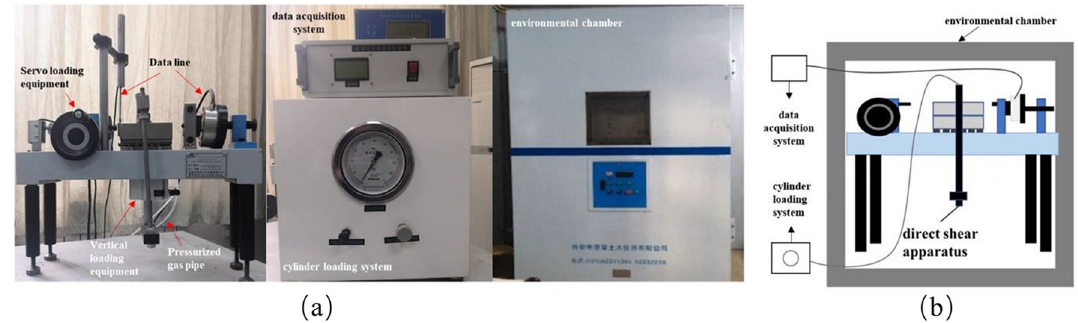
Figure 3. Frozen soil direct shear apparatus: ( a ) direct shear apparatus; ( b ) data acquisition system and cylinder loading system; ( c ) environmental chamber; ( d ) Diagram of test equipment.